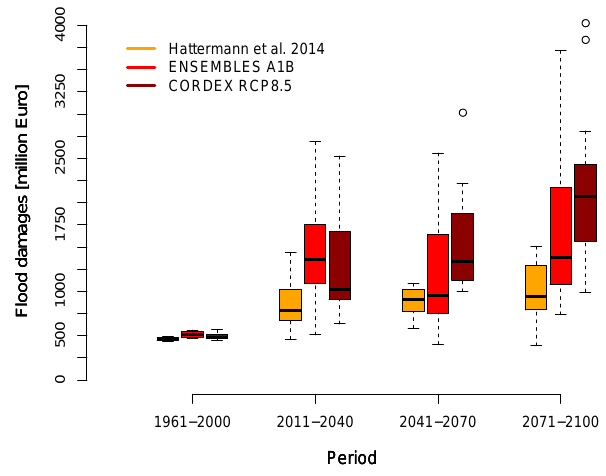
Figure 1. The annual losses per year in Germany simulated with different ensembles of climate projections as input. The bottom and top of the box give the first and third quartiles, the band inside the median and the whiskers give the upper and lower 1.5 interquartile